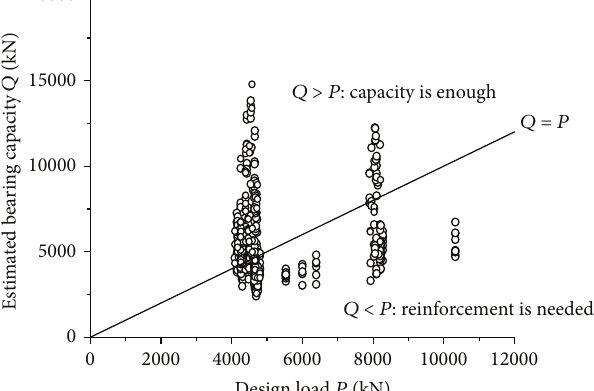
Figure10:Relationshipbetweenthecalculatedbearingcapacityand bearing design load (680 samples).